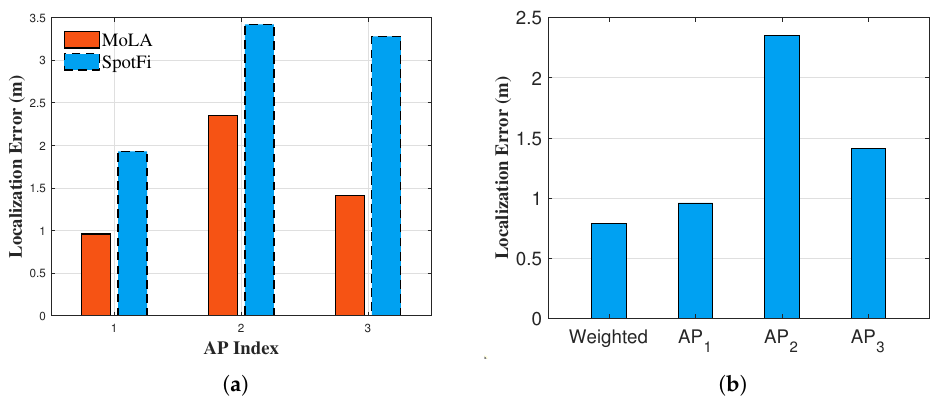
Figure 7. Comparison of localization errors with different APs. ( a ) Localization error of MoLA and SpotFi at three different AP locations; ( b ) localization error using a single AP and the weighted